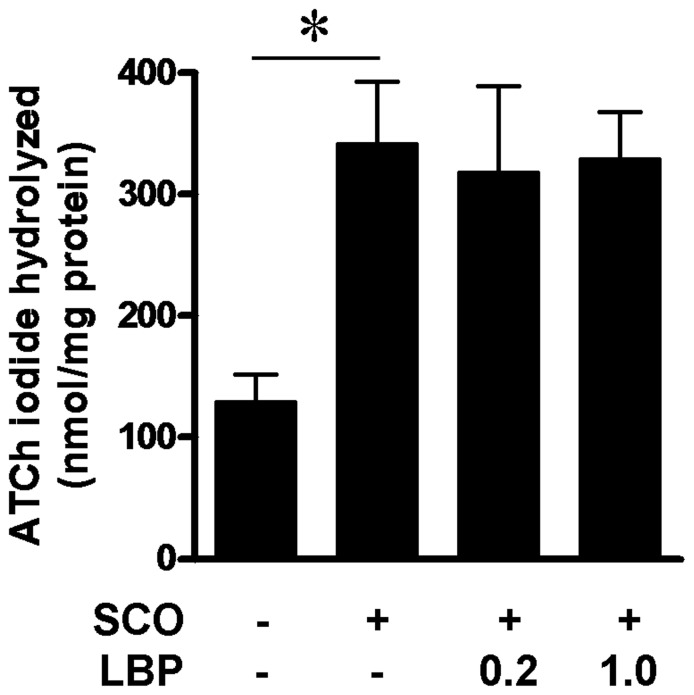
Effects of LBP on the levels of AChE in the hippocampus of the vehicle, scopolamine (SCO), SCO+LBP groups (n = 4 animals per group).The AChE substrate acetylthiocholine in the kits is incubated with hippocampal homogenates. Quantification of the thiocholine produced from the hydrolysis of acetylthiocholine reflects the AChE activities. Values are means ± SEM; *,P<0.05 vs. SCO alone-treated group.